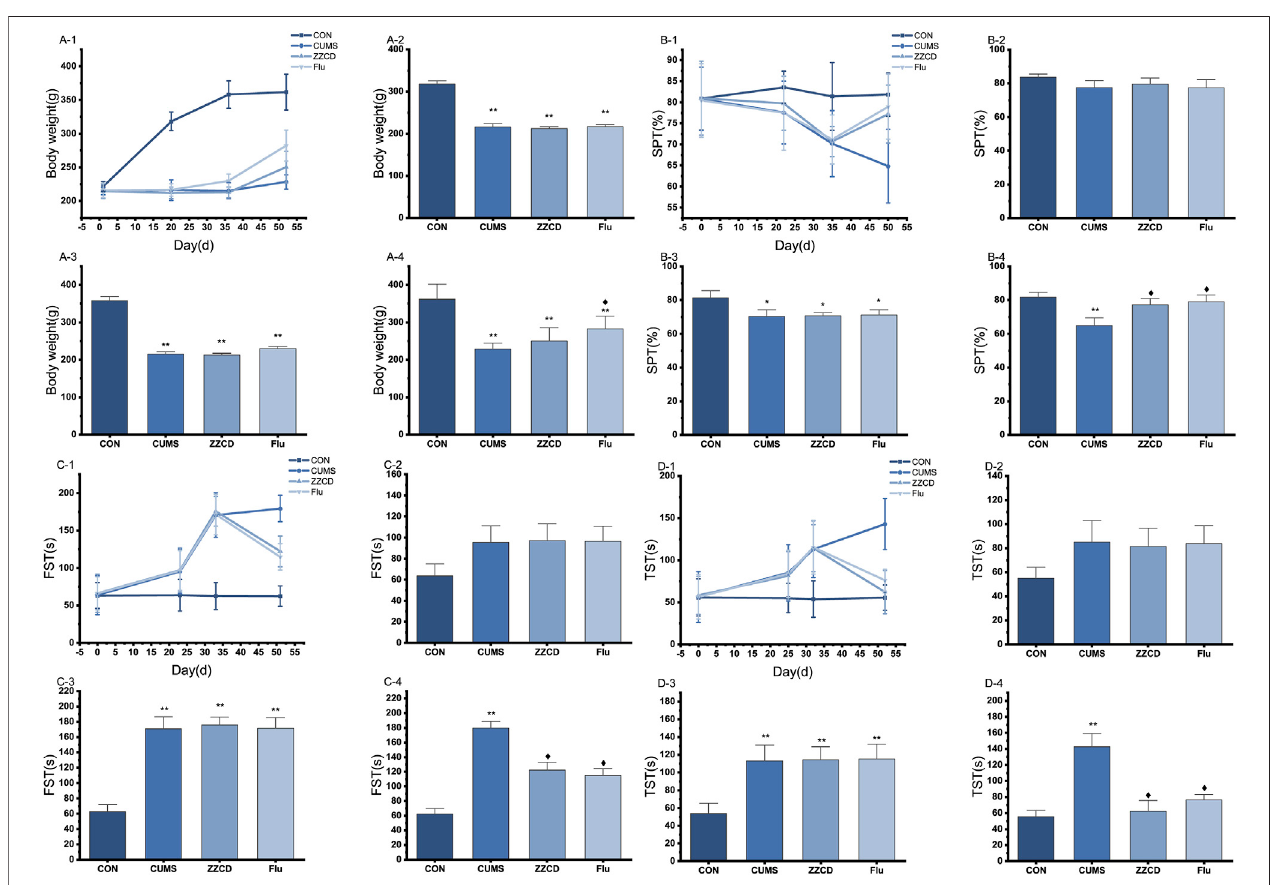
FIGURE1| Thechangeofbodyweightofratsinfourgroupduring52 days (A-1) ,on20thday (A-2) ,on36thday (A-3) ;on52ndday (A-4) .Thechangeofsucrose preference rate in four groups during 50 days (B-1) , on 22nd day (B-2) , on 35th day (B-3) ; on 50th day (B-4) . ( ‾ axis, n =8). The change ofimmobility time in FST infour groupsduring51 days (C-1) ,on23rdday (C-2) ,on33rdday (C-3) ;on51stday (C-4) .ThechangeofimmobilitytimeinTSTinfourgroupsduring52 days (D-1) ,on25th day (D-2) , on 32nd day (D-3) ; on 52nd day (D-4) . * p < 0.05 vs. CON; ** p < 0.01 vs. CON; ◆ p < 0.05 vs. CUMS.